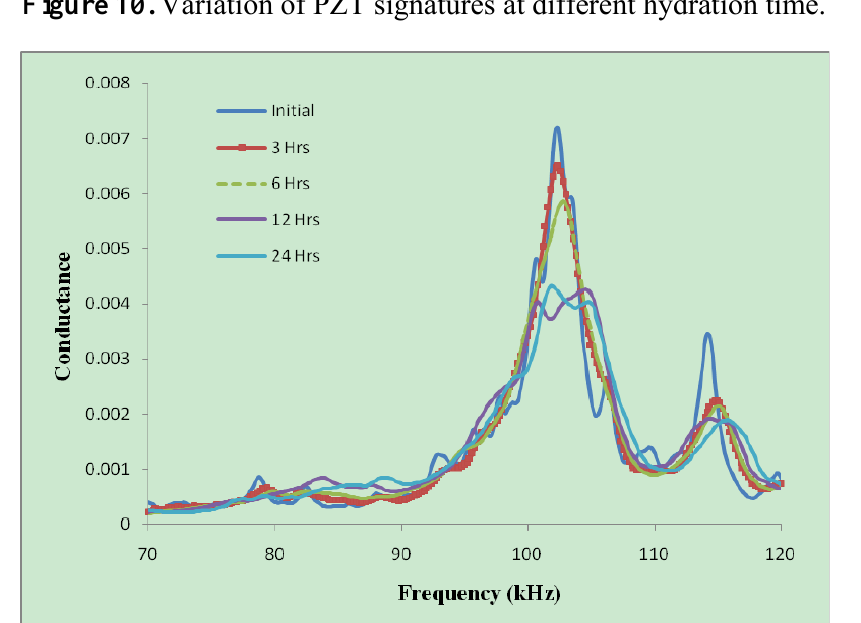
Figure 10. Variation of PZT signatures at different hydration